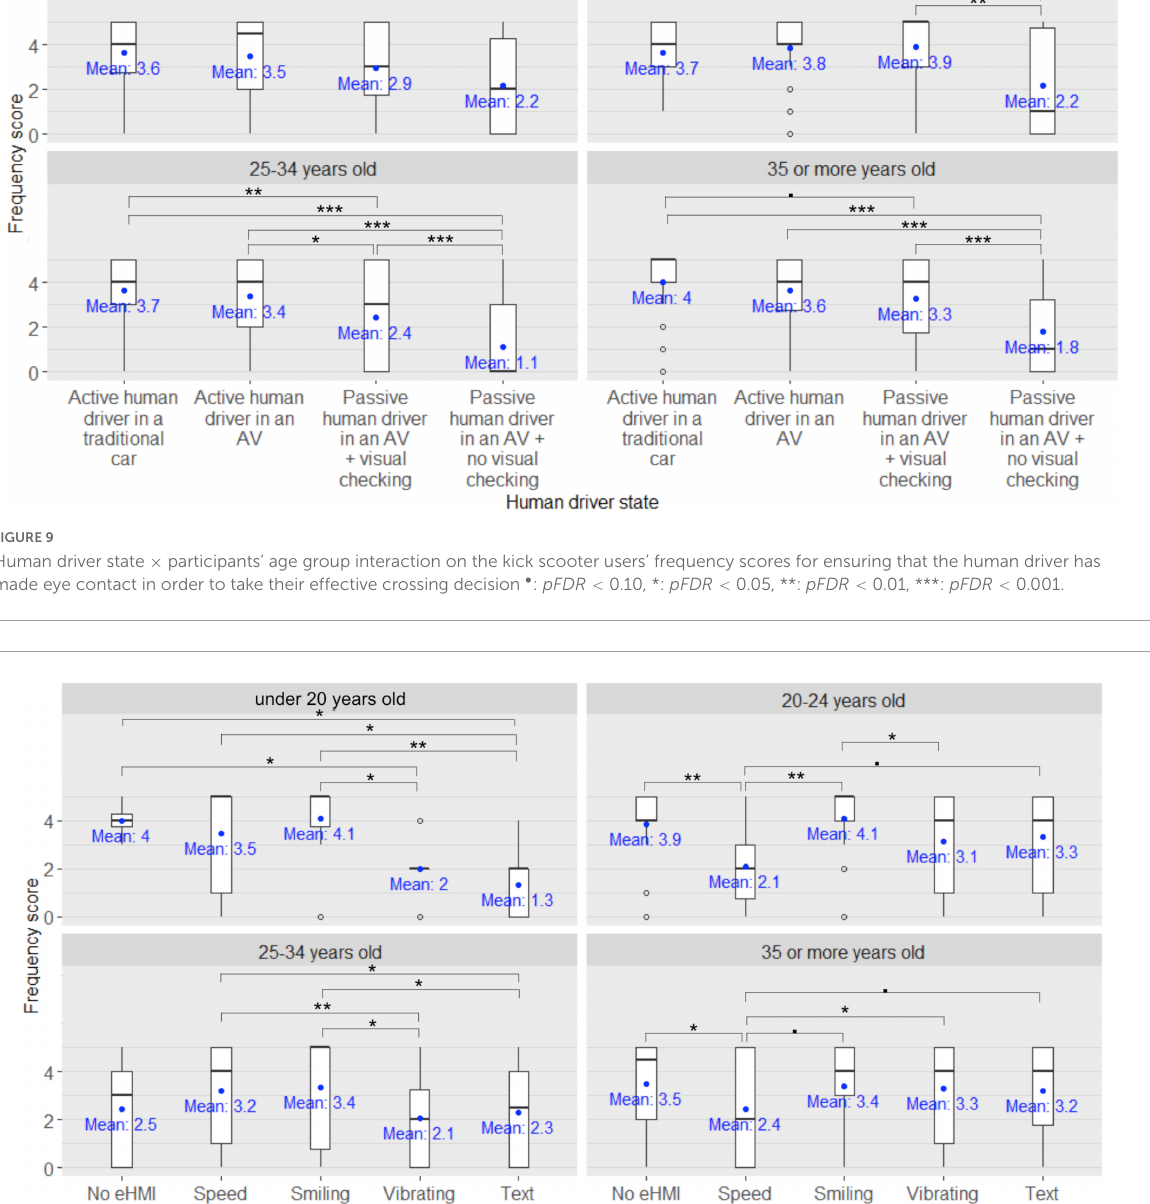
the vibrating mobile app compared to when the approaching car displayed the smiling screen ( pFDR = 0.01) or the speed screen ( pFDR = 0.008). Similarly, their frequency scores